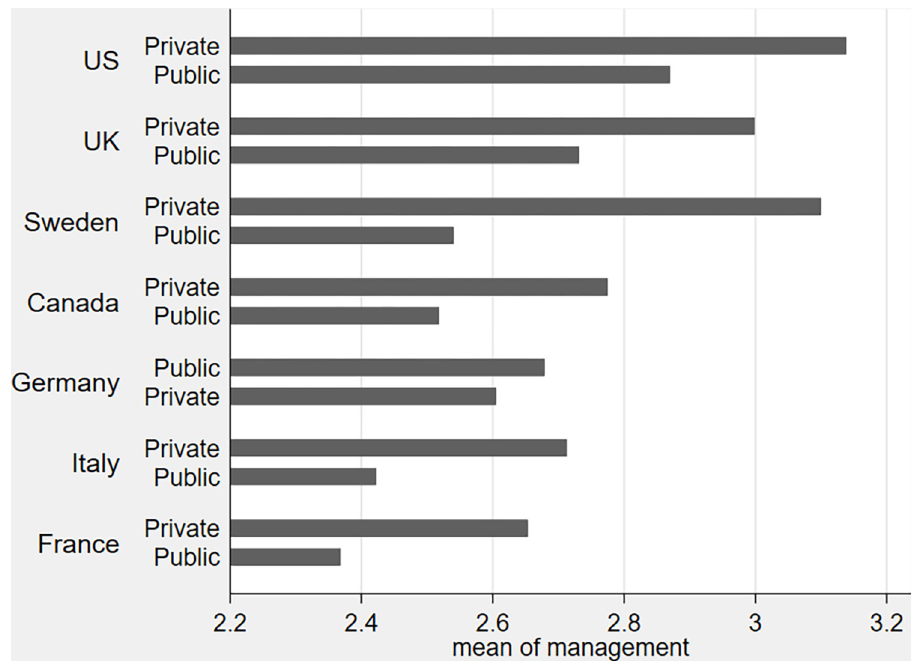
Fig 1. Public-private average management practices scores (by country). Source: World Management Survey (Hospitals sub-sample).